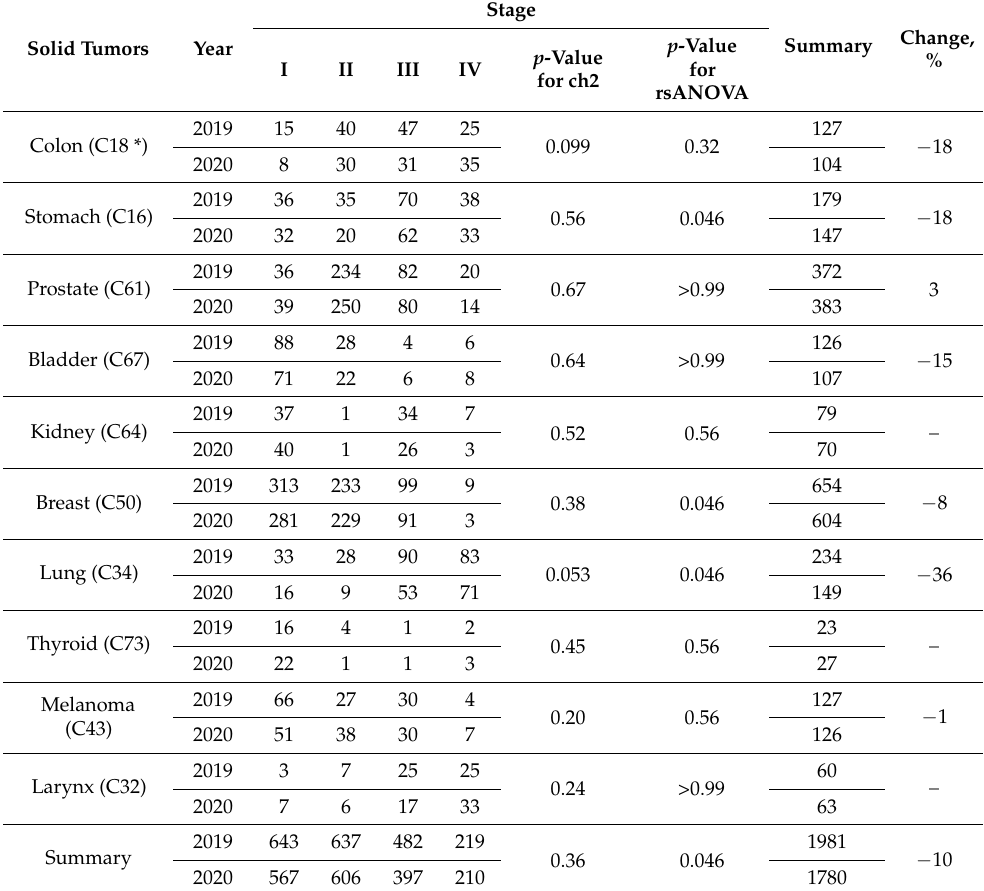
Table 3. The number of newly diagnosed cancer patients treated by surgery.